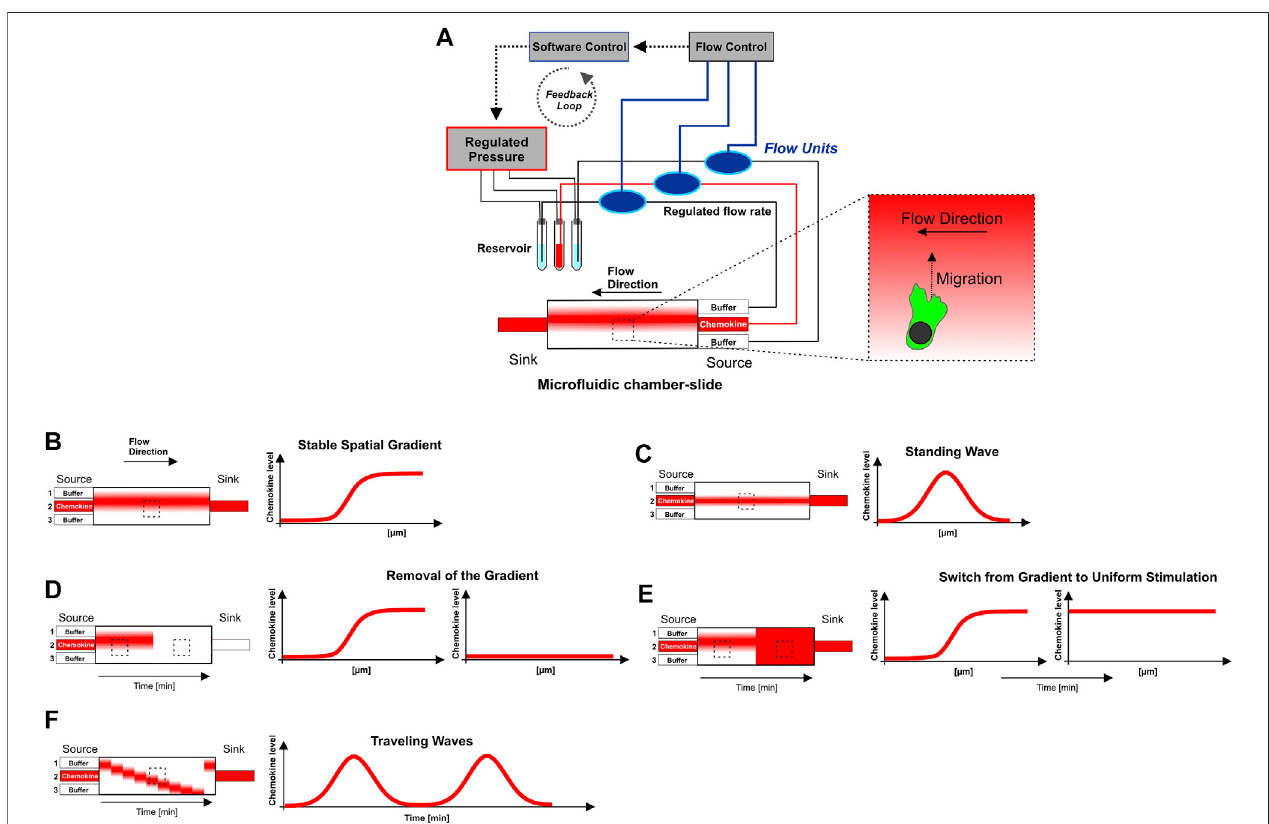
FIGURE 1 | Micro fl uidic approach to generate sigmoidal shaped concentration gradients with high spatio-temporal precision. (A) Graphical representation of the “ source-sink ” -based micro fl uidic setting. The core piece of this approach consists of a chamber-slide in which the cells are placed before they are exposed to the gradient. In the “ source-sink ” -based micro fl uidic approach, laminar fl ows from three independent source channels were merged and hydro-dynamically focused to generatesolubleconcentration gradients ofchemokines with asigmoidal-shaped concentration pro fi le.The three inlet channels (source) areconnected via fl exible tubes to centrifuge tubes, which are used as a reservoir of the fl ow buffer source (central inlet: chemokine + fl uorescent 10 kDa-Dextran, both outer inlets: fl ow buffer without chemokine). One more fl exible tube is connected to the outlet (sink) and ends in a waste vessel. Pressure is controlled via a pneumatic pressure regulator. High precision bidirectional fl ow sensors interfaced with control software allows for direct feedback control and monitoring of individual fl ow rates. Pressure control is automated by control software using custom-made scripts that set the fl ow rates from the individual inlet dynamically over time. (B – F) Graphical representation of fl ow- basedsolublesteady-state (stablegradient, standingwave)and dynamic chemokine environments(removal ofthegradient, switch from gradienttouniformstimulation, and traveling waves). Forthe generation ofdynamictraveling waves modi fi ed executable shell scripts from Nakajima and Sawai (2016) are used. The observation region within the micro fl uidic chamber-slide is indicated by the rectangle with the dashed line. Chemotaxis of cells towards the gradient is perpendicilar to fl ow direction. The experimentalsetupisexplainedindetailinthe MaterialsandMethods section. SupplementaryTableS1 summarizes fl owratesaswellasthespatio-temporalcondition of the gradient (stable, dynamic) which were used in respective